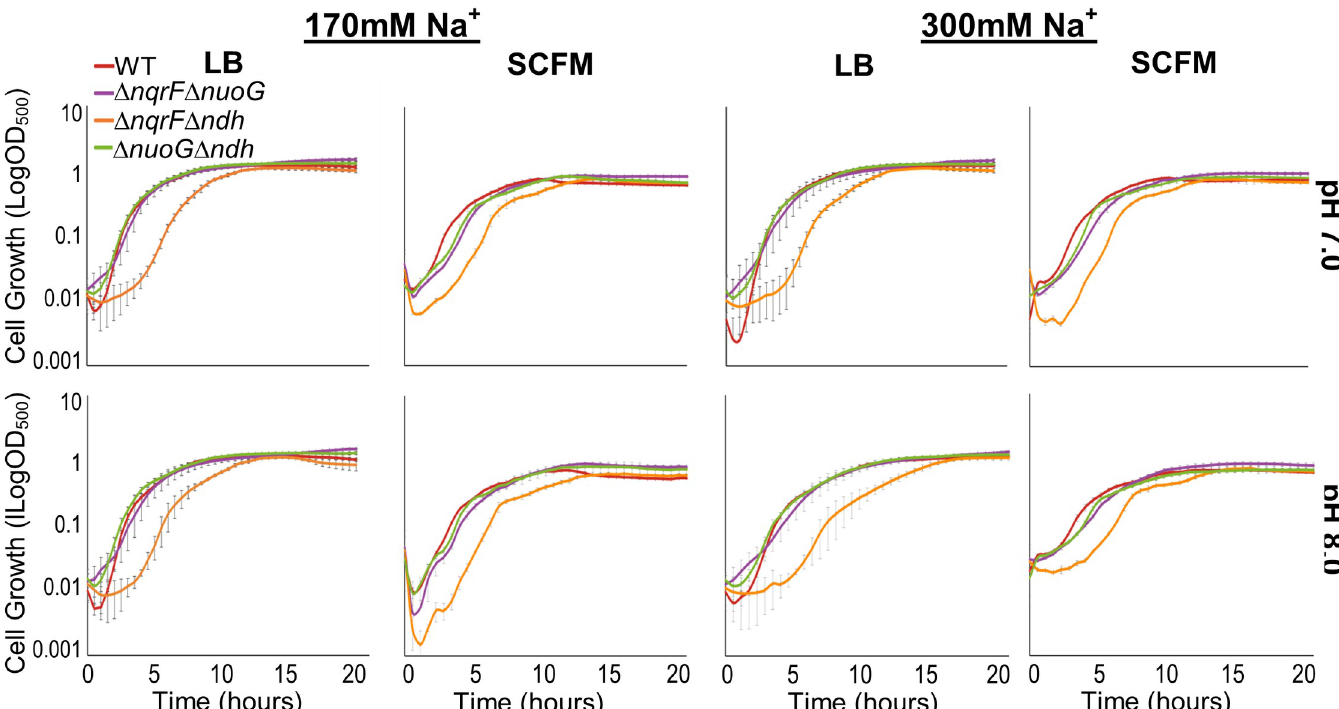
Fig 2. Comparison of growth of wild type and double deletion mutant strains. Growth curves of wild type PAO1 (red) and double deletion mutants Δ nuoG Δ ndh (green), Δ nqrF Δ ndh (orange), and Δ nqrF Δ nuoG (purple) plotted in log 10 scale in LB and SCFM media at 170mM and 300mM NaCl concentrations, at pH 7.0 and 8.0. Changes in OD 500 were measured using a Tecan Infinite M1000 Pro plate reader during 20 hours of growth at 37˚C with continuous orbital shaking at 217 rpm. Each curve was constructed using two biological replicates with three technical replicates each, with standard deviation calculated accordingly and represented as error bars.